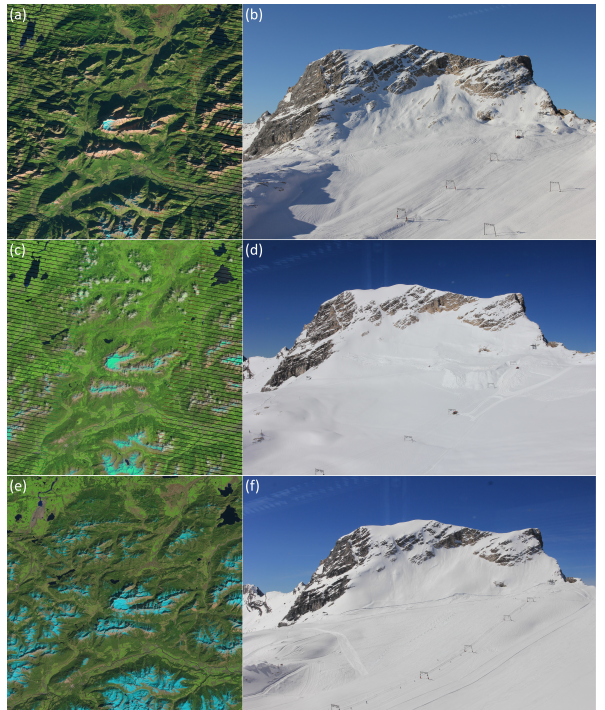
Figure 2. Enlarged view of the Landsat Look images of Zugspitz- platt (in the centre) and SLR photographs of Schneefernerkopf for 17 November 2011 (a, b) , 1 July 2013 (c, d) , and 7 April 2014 (e, f) : snow cover extents are generally depicted in cyan colours in the Landsat scenes. (a, b) show about 1 month old snow with strong shadowing effects and some partial cloud coverage (not visible in the Landsat Look image). (c) and (d) display fresh snow and have a significant but partial cloud coverage. (e) and (f) also show fresh snow but under clear conditions and with some weak shadowing